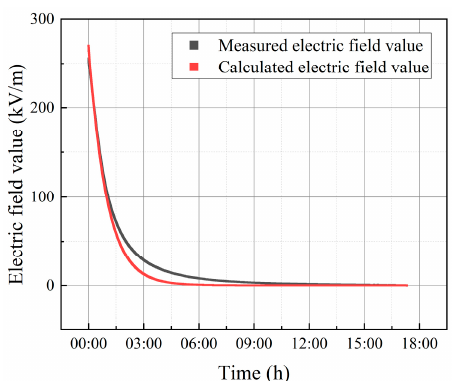
Figure 5. Comparison of the measured and calculated electric field values in charge decay.